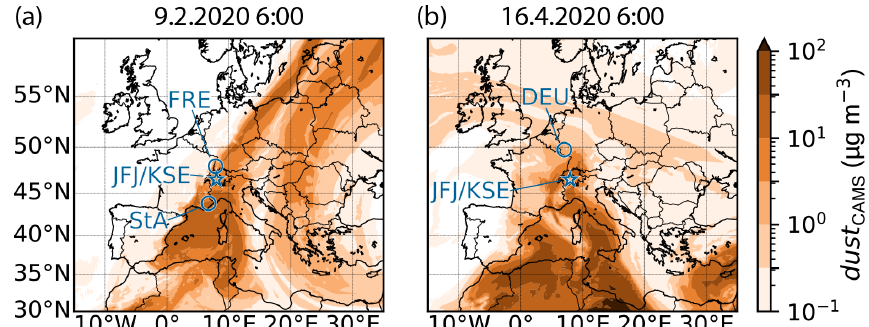
Figure 10. Snapshot of the spatial distribution of dust CAMS during two dust events: ( a ) 9 February, 06:00UTC, and ( b ) 16 April, 06:00UTC, with the locations of the ceilometers Freiburg (FRE), Kleine Scheidegg (KSE), Saint-Auban (StA), and Deuselbach